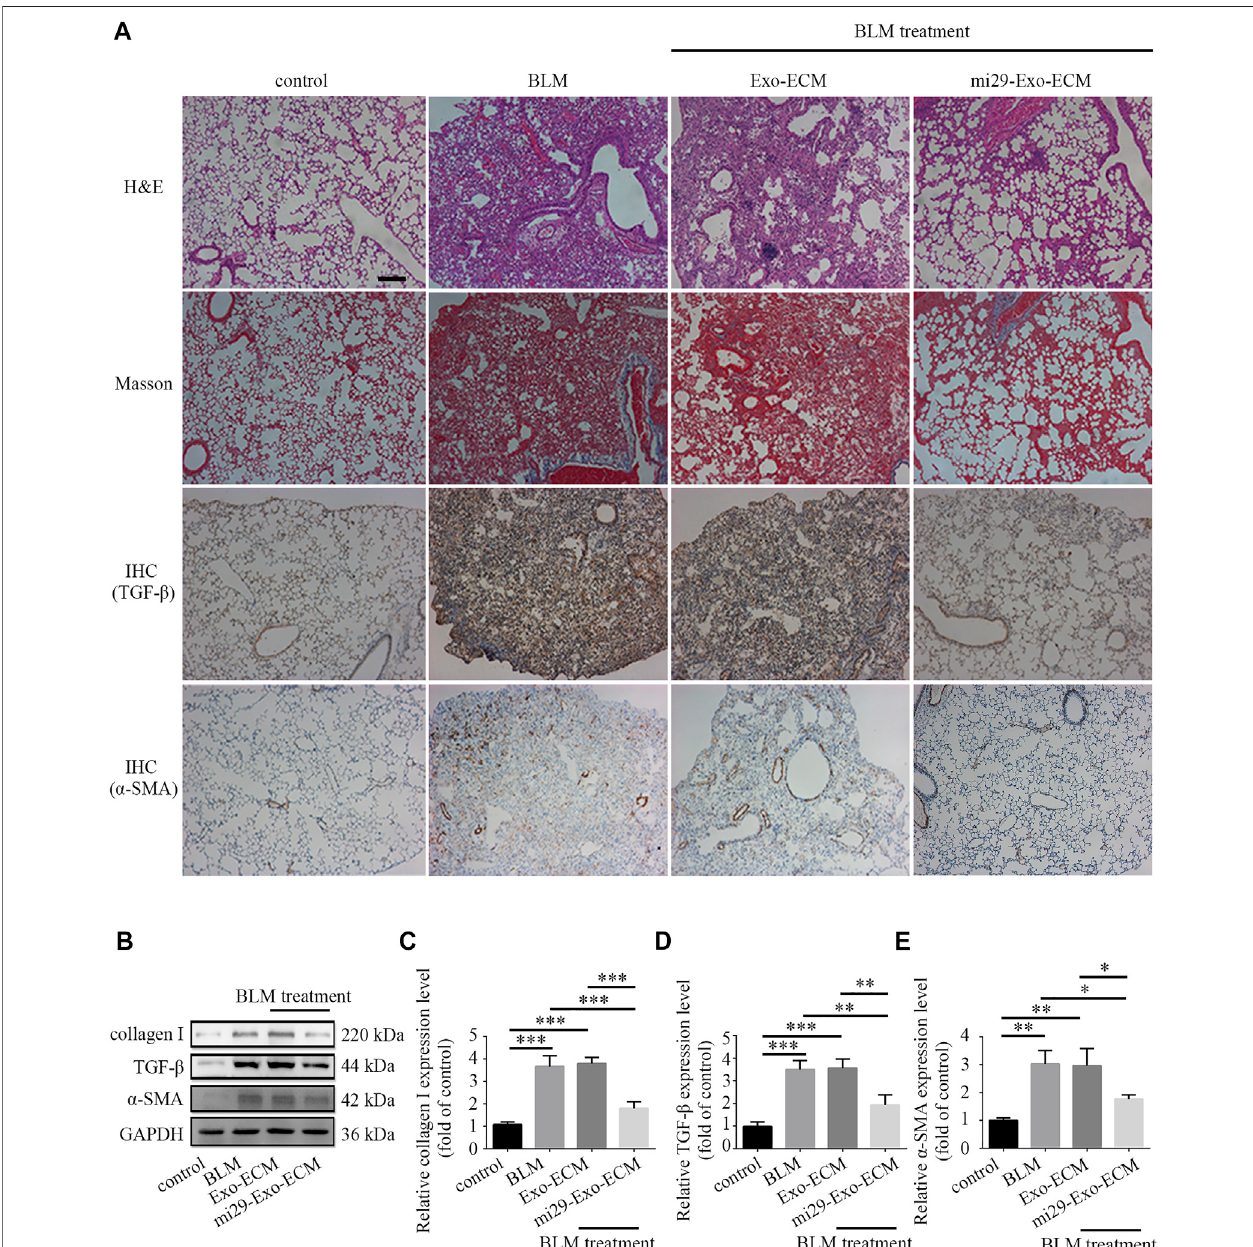
FIGURE 6 | Pulmonary fi brosis therapeutic potential of mi29-Exo-ECM biomaterial. (A) H&E staining, Masson staining and IHC of lung tissues from mice treated withBLM,Exo-ECMbiomaterial,mi29-Exo-ECMbiomaterial.Scalebar (cid:1) 1,000 μ m. (B) ThechangesofcollagenI,TGF- β and α -SMAproteinlevelsinpulmonary fi brosis mice after treated with mi29-Exo-ECM biomaterial. Relative expression levels of collagen I (C) , TGF- β (D) , α -SMA (E) were quanti fi ed. “ Control ” : no treatment mice; “ BLM ” : bleomycin-induced pulmonary fi brosis mice model; “ Exo-ECM ” : Exo-ECM treatment; “ mi29-Exo-ECM ” : mi29-Exo-ECM treatment; Data are represented as mean ± SD ( n (cid:1) 5). ANOVA was performed; “ * ” : p < 0.05; “ ** ” : p < 0.01; “ *** ” : p < 0.001.